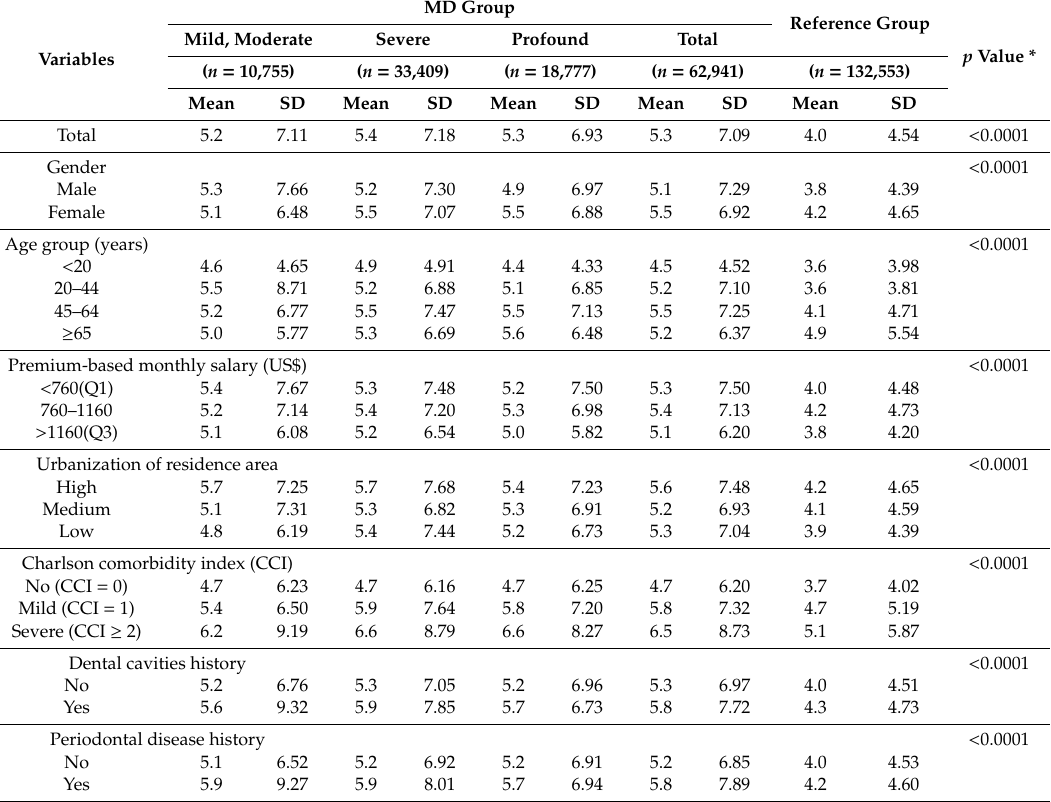
Table 4. Visits of respiratory infections utilization among only use individuals in the MD and reference